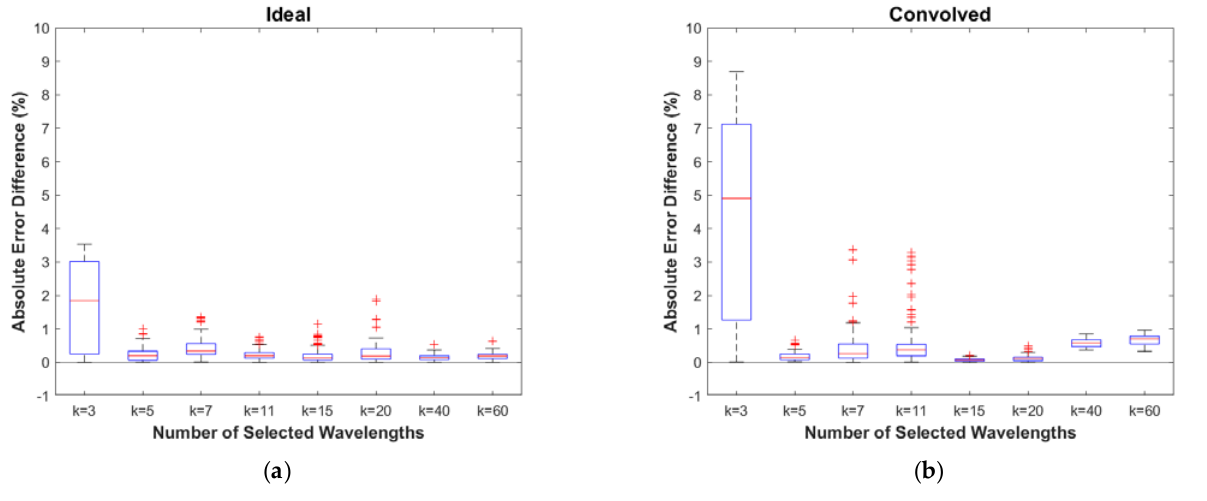
Figure 9. Results of the stability testing for ( a ) the ideal case and ( b ) the convolved case. Boxplots are based on the differences in prediction error between the values for the adjusted wavelength sets and those for the exact wavelengths selected by the simulated annealing algorithm.